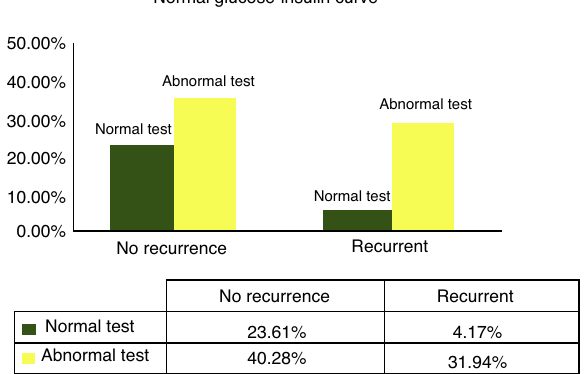
Figure 1 Distribution of patients with BPPV recurrence, regarding glucose---insulin tests within normal limits.